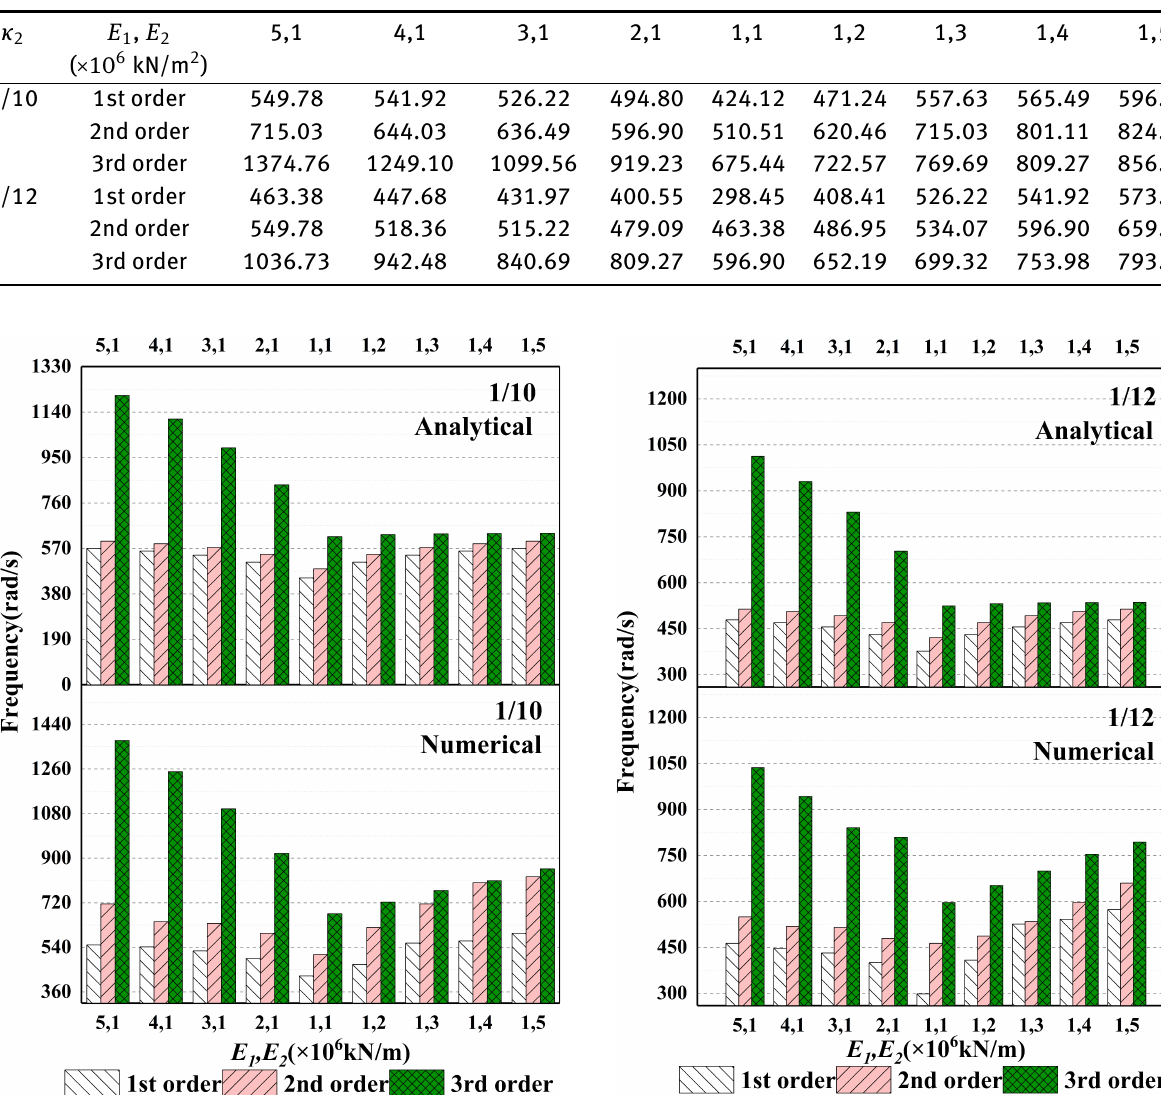
Table 5: The natural frequencies (rad/s) of numerical solutions under different elastic modulus ratios and rise span ratios